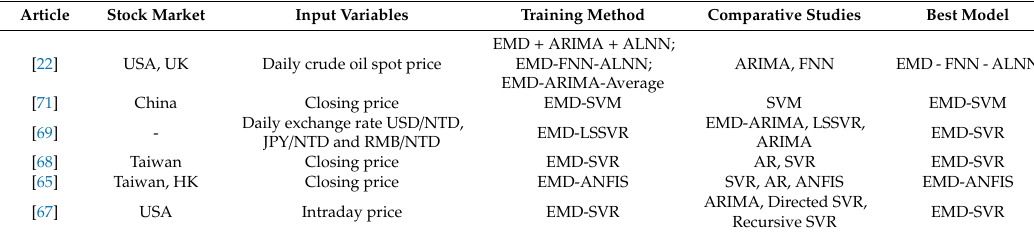
Table 5. Summary of empirical mode decomposition (EMD)-based prediction methods used by this study’s references.